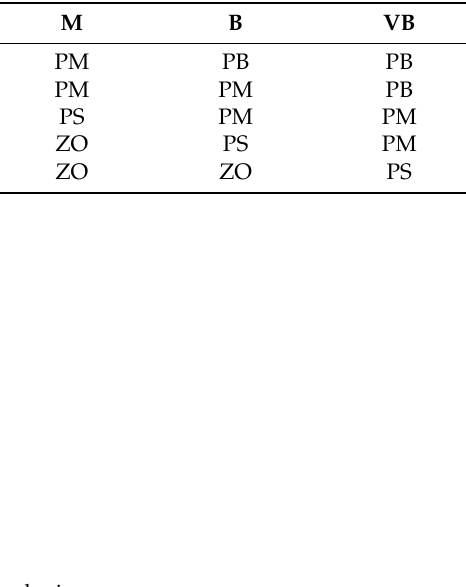
Figure 7. Input and output surface diagram of fuzzy logic.